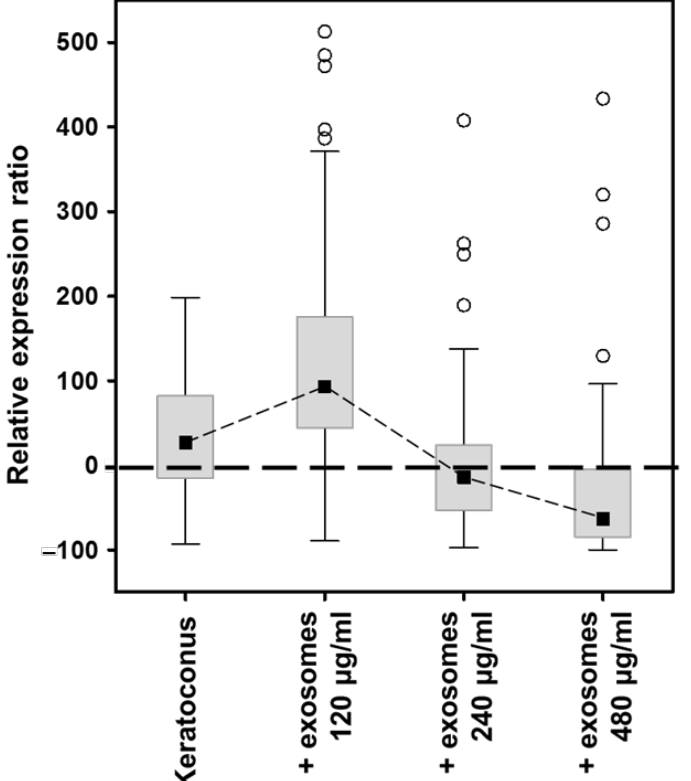
Figure 7. Alteration in the gene expression of KC cells induced by exosomes produced by healthy stromal cells. The relation of the relative expression of genes encoding HSPGs and SLRPs in corneal stromal cells of patients with KC cultured alone or in the presence of exosomes isolated from healthy cell cultures at concentrations of 120, 240 and 480 µg of protein/mL are shown. The expressions are referenced to the values of healthy cells, represented by the line at 0. The black squares represent the median of the values; the rectangles, the 25 to 75% range of values; the spreads the non-outlier range; and the circles the outliers.